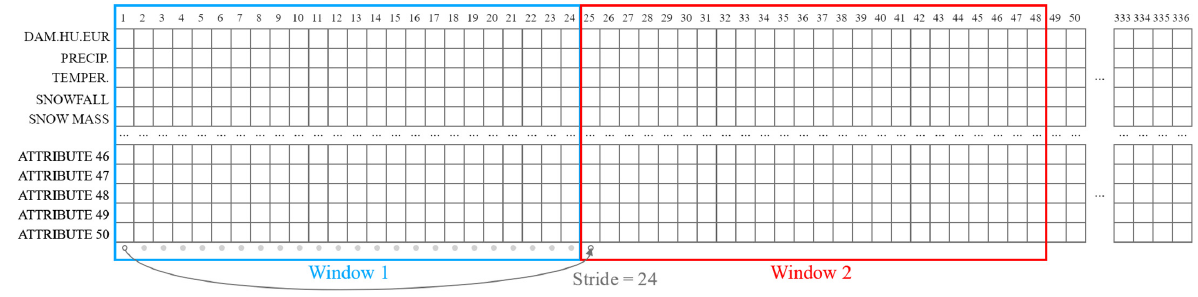
Figure 5. TCN windows for price prediction model.